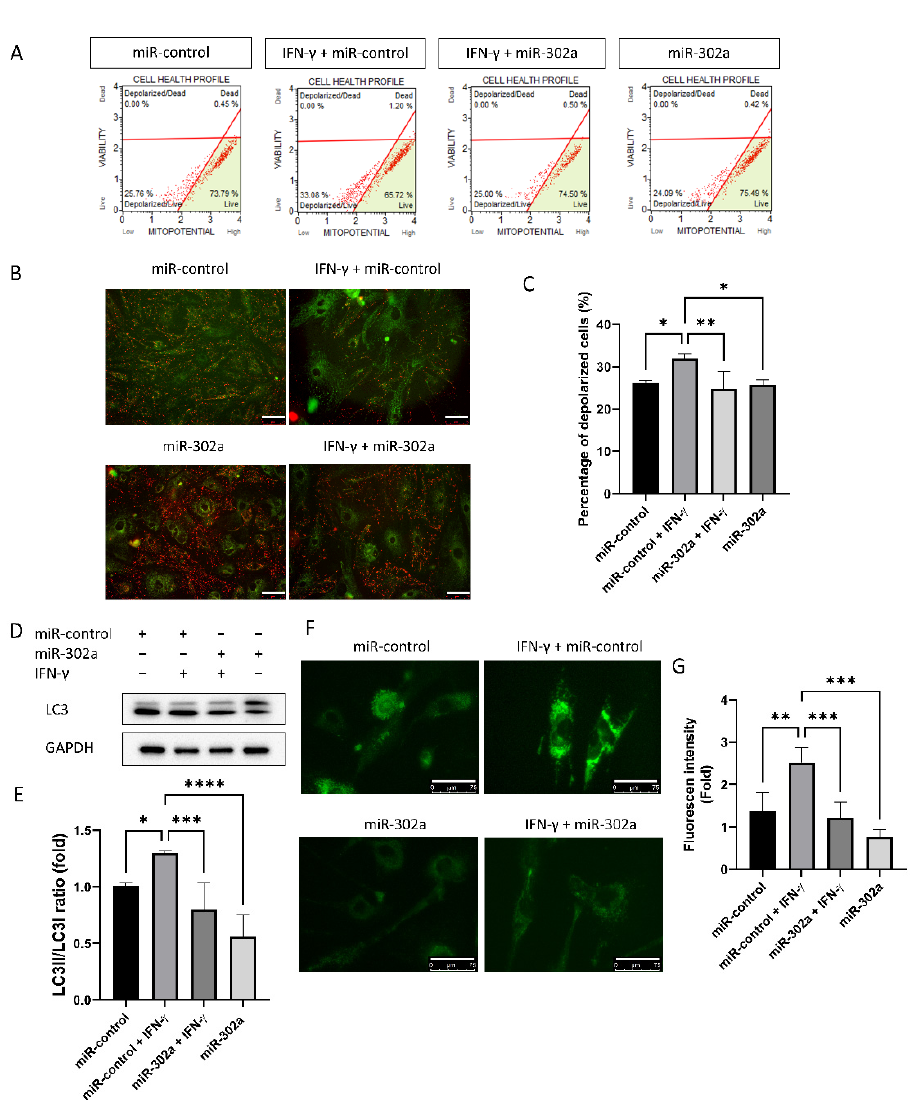
Figure 4. Effect of miR-302a on IFN- γ -induced cell death. ( A – C ) Mitochondrial membrane potential was measured by cell analyzer using Mitopotential kit, and by fluorescence imaging using JC-1 with or without IFN- γ or miR-302a. Scale bar = 75 µ m. ( D , E ) Autophagy was measured by the conversion of LC3I to LC3II. ( F ) Autophagosome was stained using autophagy detection kit. Scale bar = 75 µ m. ( G ) Fluorescence intensity of autophagosome was measured using autophagy detection kit. Data presented as mean ± S.D. * p < 0.05, ** p < 0.01, *** p < 0.001 and **** p <